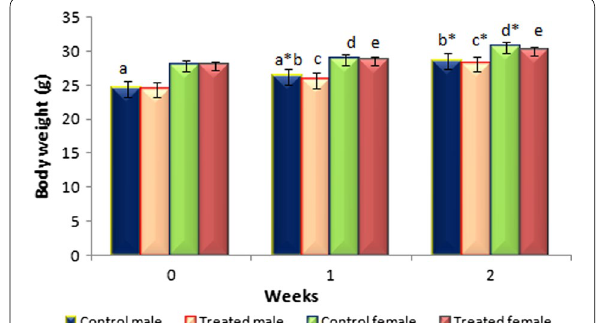
Fig. 5 Mean body weight of mice upon dosage of Berberis aristata diterpenes. Values are expressed as mean group). Same superscript alphabetic letters above the bars show significant statistical difference. Asterisk denotes (p indicated by Post hoc Tukey’s t-test